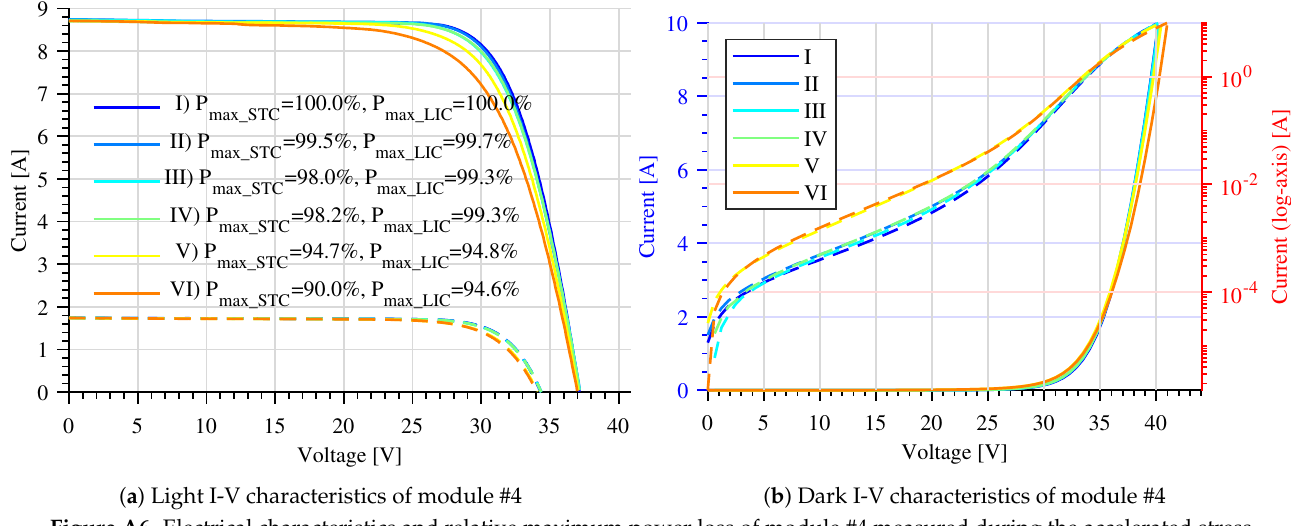
Figure A6. Electrical characteristics and relative maximum power loss of module #4 measured during the accelerated stress test: ( a ) light I-V characteristics measured at STC and low irradiance conditions (LIC, 200 W/m 2 ); ( b ) dark I-V characteristics of module #4 measured at 25